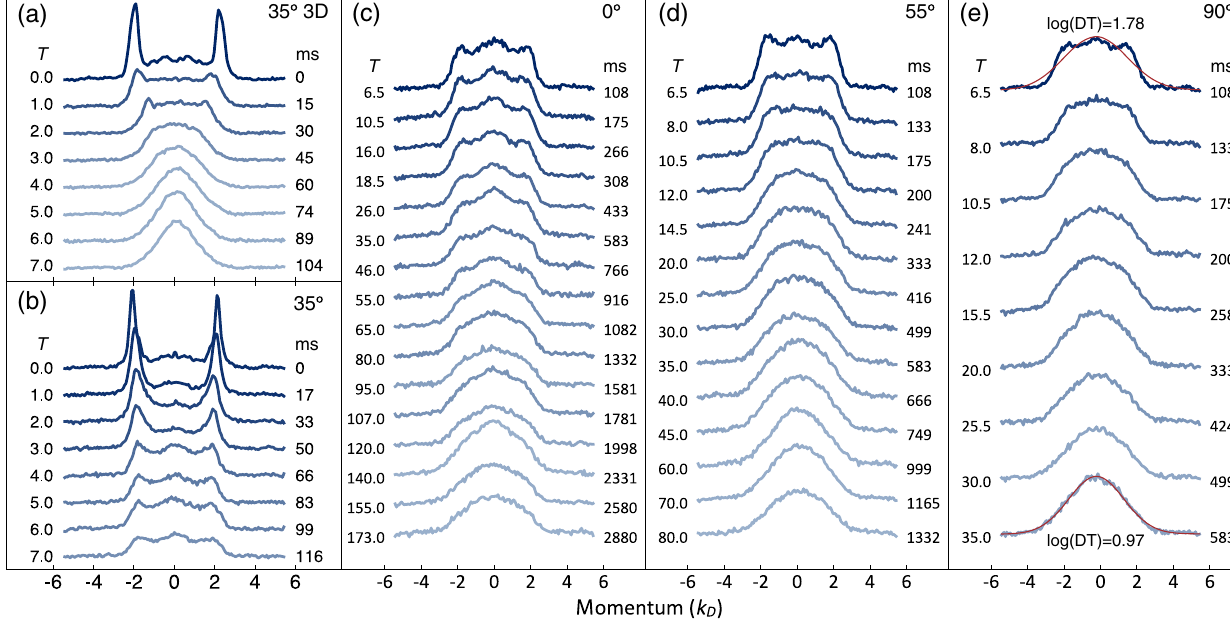
FIG. 2. Evolution of postkick momentum distributions at multiples of T . (a) 3D gas at θ ¼ 35 °. (b) Regime I, fast dephasing of the 1D gas at θ ¼ 35 °. While the momentum distribution of the 3D gas thermalizes after about 5 T , the 1D gases exhibit nonthermal (i.e., non-Gaussian) distributions far longer. The remaining panels show 1D gases in regime II for θ ’ s of (c) 0°; (d) 55°; and (e) 90°. We diffract and evolve with θ ¼ 35 ° until rotation at 5 T to the target θ . As can be seen in panels (c) – (e), this procedure produces nearly identical momentum distributions after field rotation regardless of θ . The color scale is proportional to the distance to thermalization. The best-fit Gaussian curve and the corresponding log(DT) value are shown for the 90° data at the earliest and latest